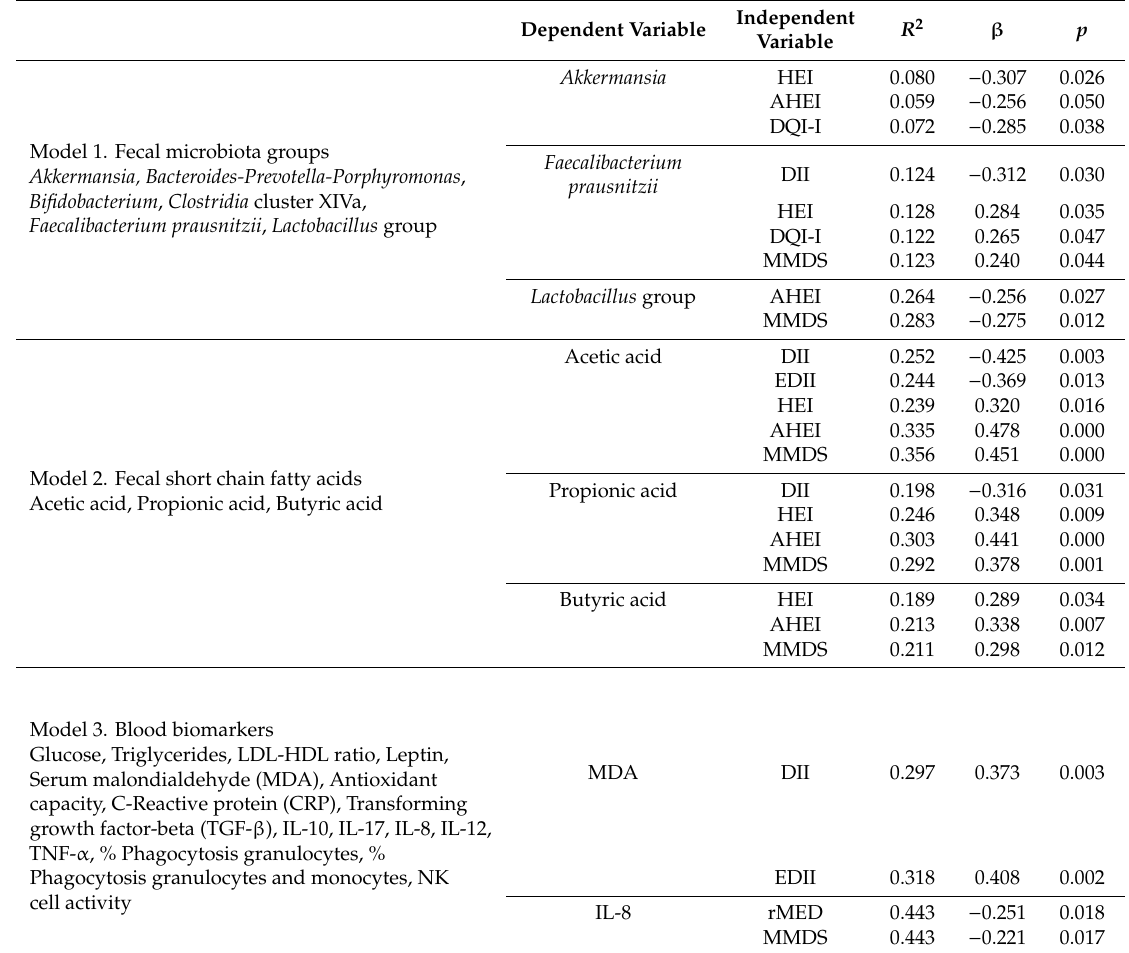
Table 3. Results obtained from regression analyses to identify dietary indices as predictors of gut microbiota levels (log 10 n ◦ . cells per gram of feces), fecal short chain fatty acids (mM) and blood